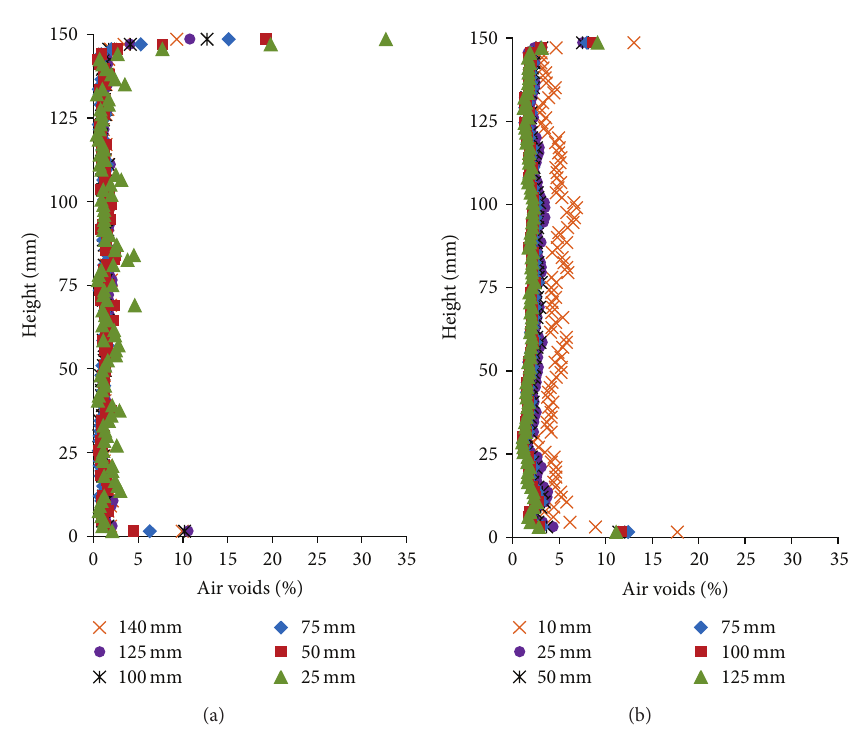
Figure 8: Air voids distribution within the virtual cut of (a) core and (b) ring for specimen